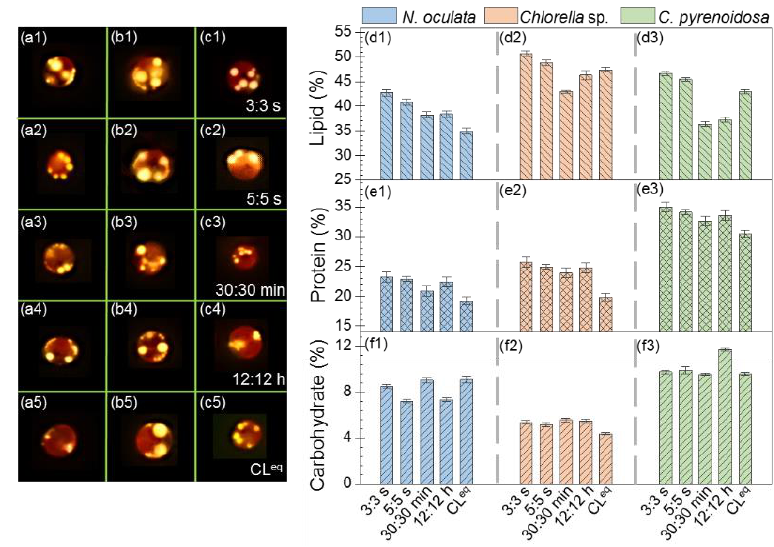
Figure 4. Fluorescence images of microalgae cultivated under different photoperiods stained with Nile Red: Nannochloris oculata ( a1 – a5 ), Chlorella sp. ( b1 – b5 ), and Chlorella pyrenoidosa ( c1 – c5 ). The lipid, protein and carbohydrate contents in microalgae cultivated under different photoperiods: Nannochloris oculata ( d1, e1, f1 ), Chlorella sp. ( d2, e2, f2 ), and Chlorella pyrenoidosa ( d3, e3, f3 ).